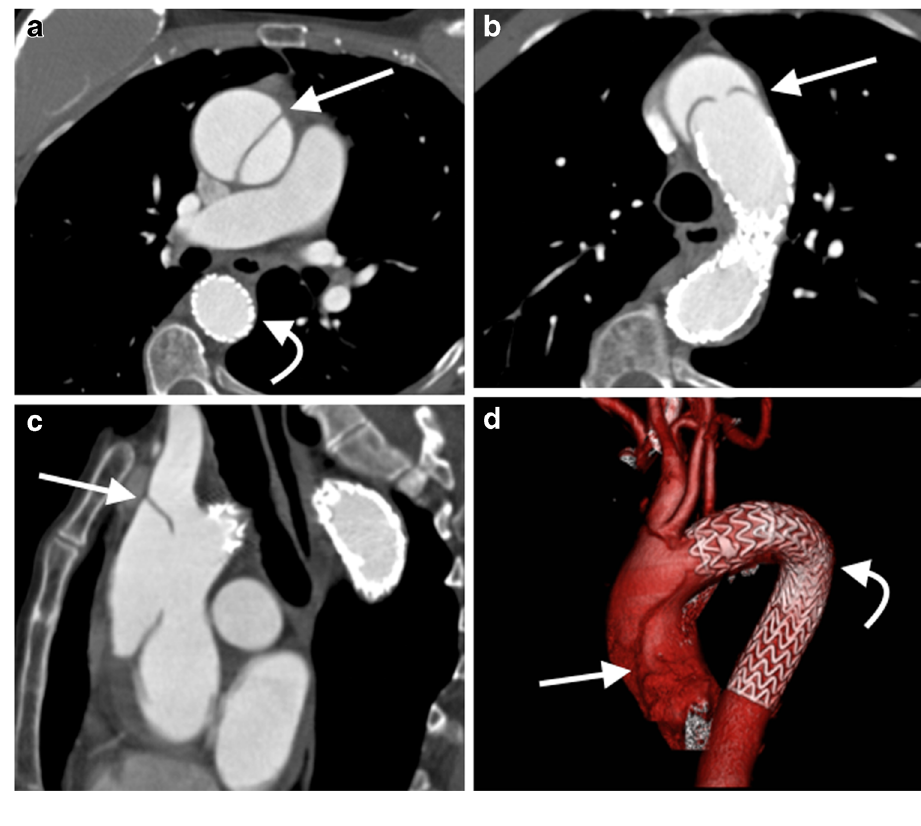
Fig. 6 A MR angiogram in a 45- year-old woman who presented with acute onset of tearing chest pain. Sagittal oblique image from a ECG gated T1-weighted post- gadolinium 3D acquisition ( a ) demonstrates a dissection flap ( arrow ) arising in the aortic arch distal to the origin of left subcla- vian artery consistent with a type B aortic dissection, with the dis- section flap extending into the abdominal aorta. Corresponding 3D segmented volume rendered image of the thoracic aorta ( b ) from the thoracic MRA demon- strates the dissection flap ( arrow ). Coronal abdominal T1-weighted post gadolinium MRA image ( c ) demonstrates the distal extent of the dissection flap ( arrow ) into the common iliac arteries bilater- ally, with a 3D segmented volume rendered image of the abdominal aorta ( d ) demonstrating the dis- section flap in the abdominal aor- ta ( arrow